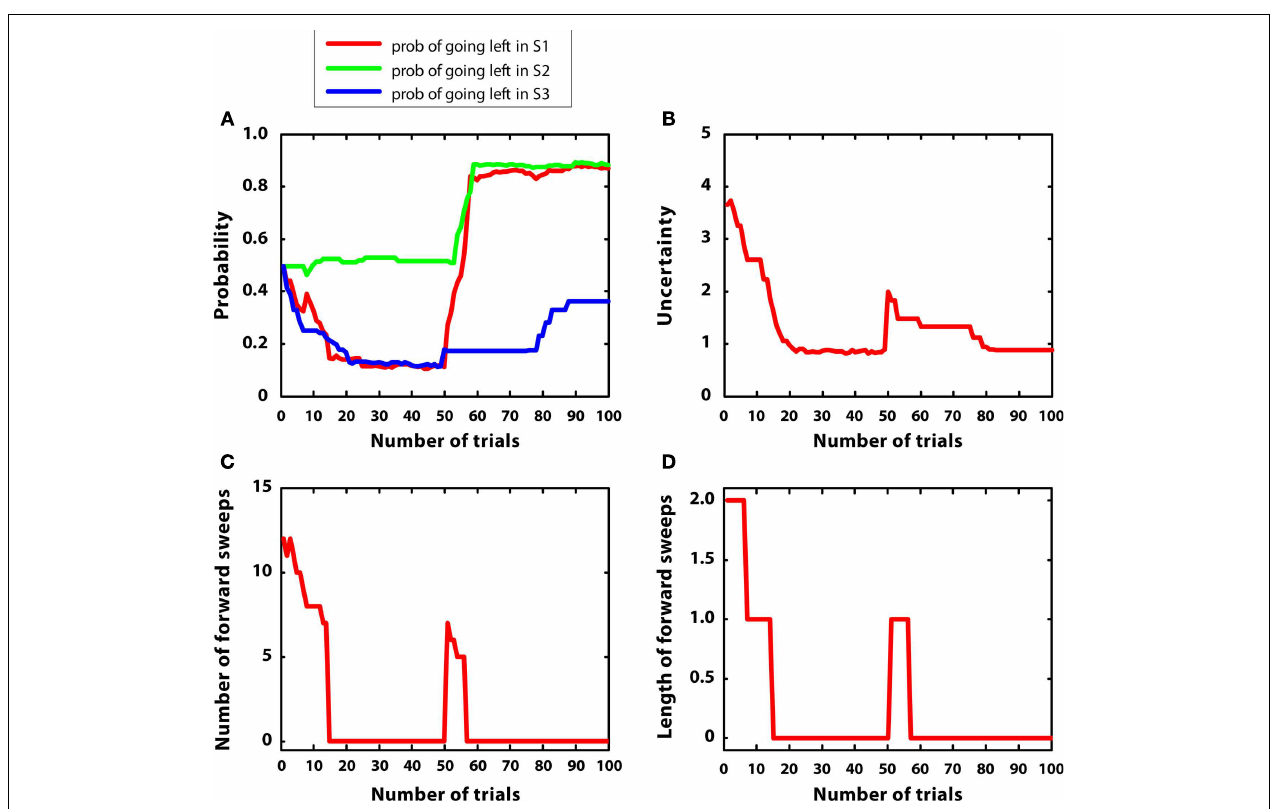
FIGURE 7 | Results of simulation 3, non-stationary environment. (A–D) : see Figure 5